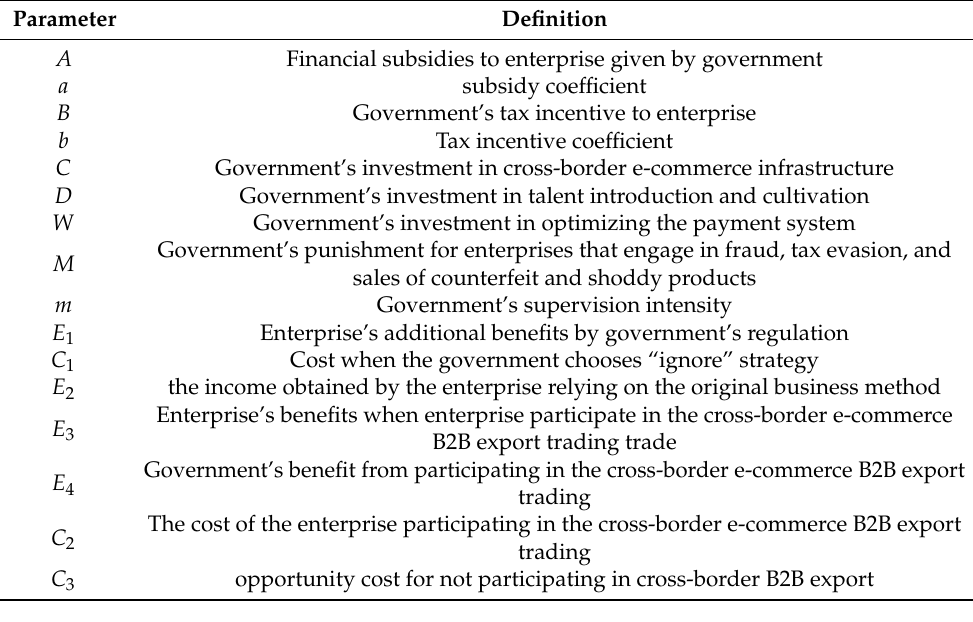
Table 4. Basic parameter assumption.